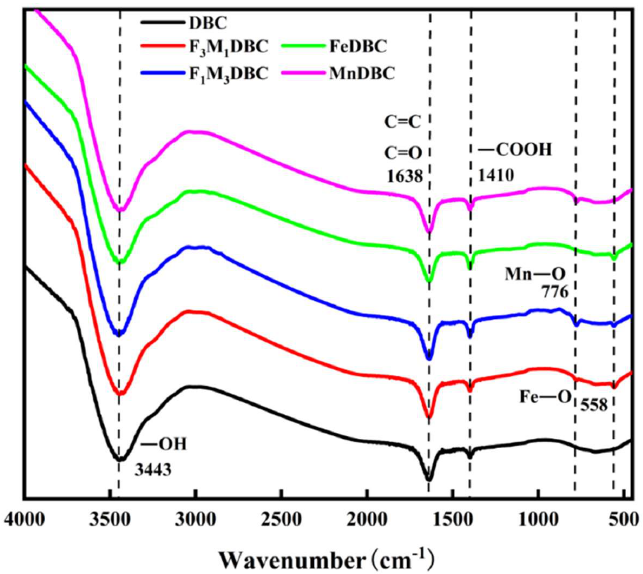
Figure 7. The FT-IR analysis of the original biochar and modified biochar before and after adsorp- tion.